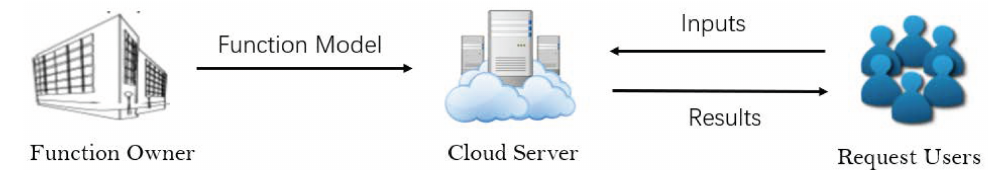
Figure 1. Outsourcing computation model of